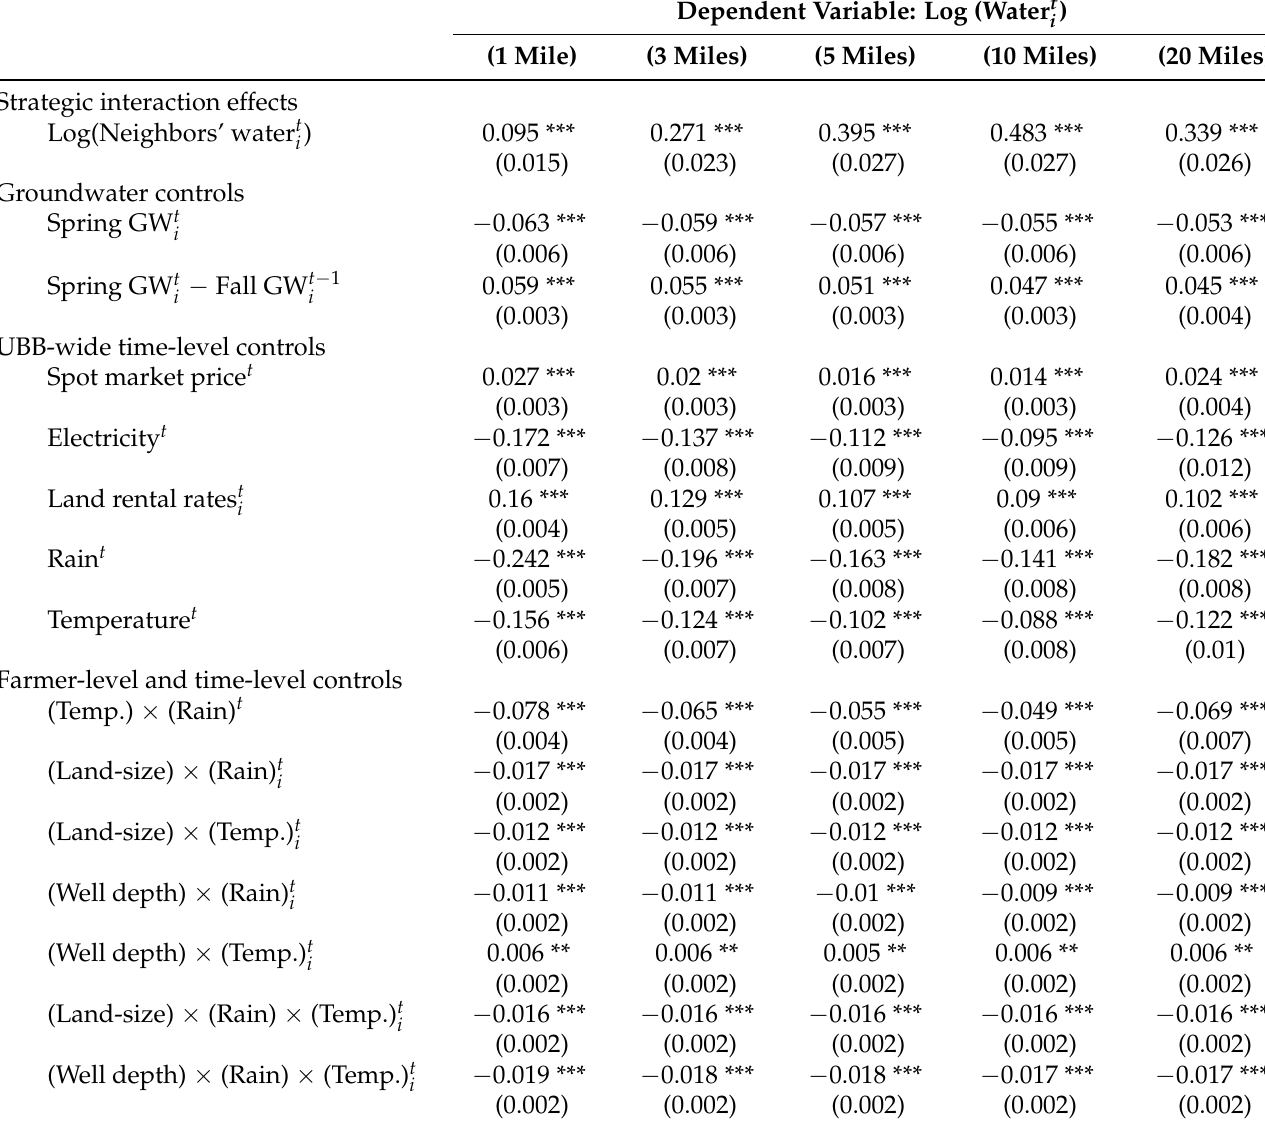
Table A2. Micro-level regressions on UBB data. Number of observations = 97,160. { 1,3,5,10,20 } mile(s) corresponds to neighborhood sizes as in Figure 4. Coefficients of control variables are normalized such that β = % water t /+1 SD variable i